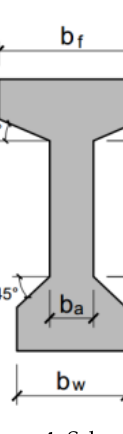
Figure 4. Schematic cross-section of the beam to be optimized.